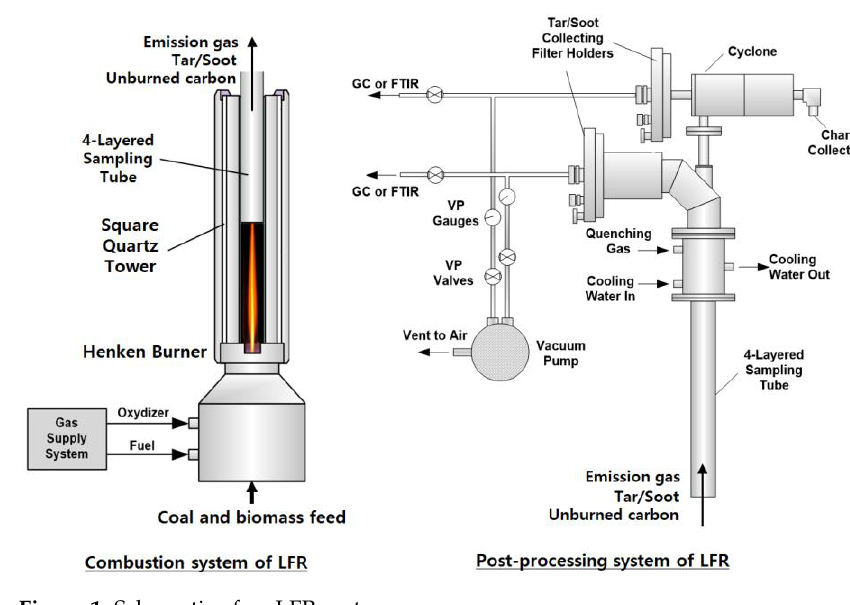
Figure 1. Schematic of an LFR system.